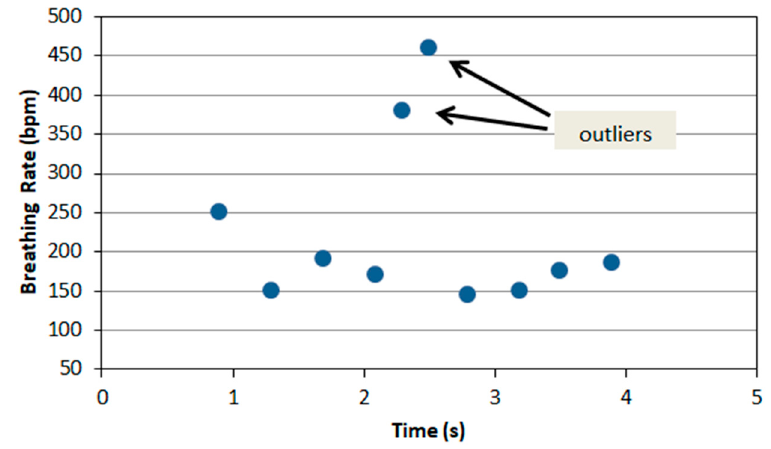
Figure 8. Calculated breathing rate.